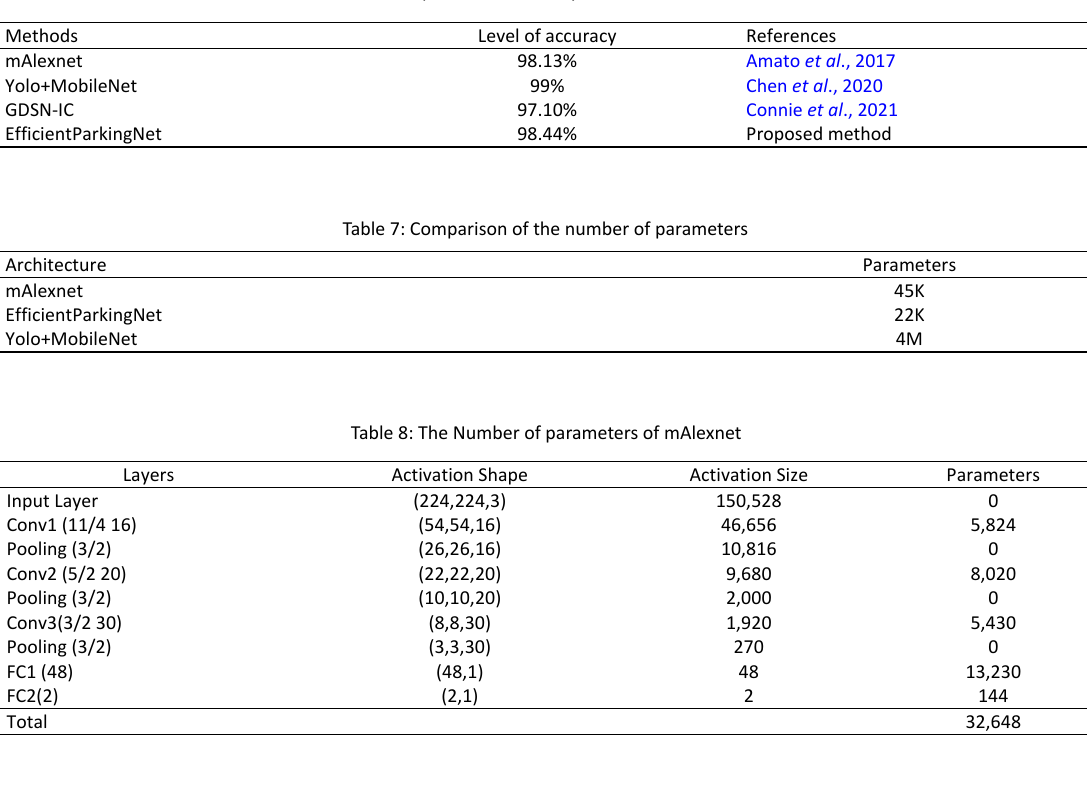
Table 6: Comparison of accuracy of several architectures